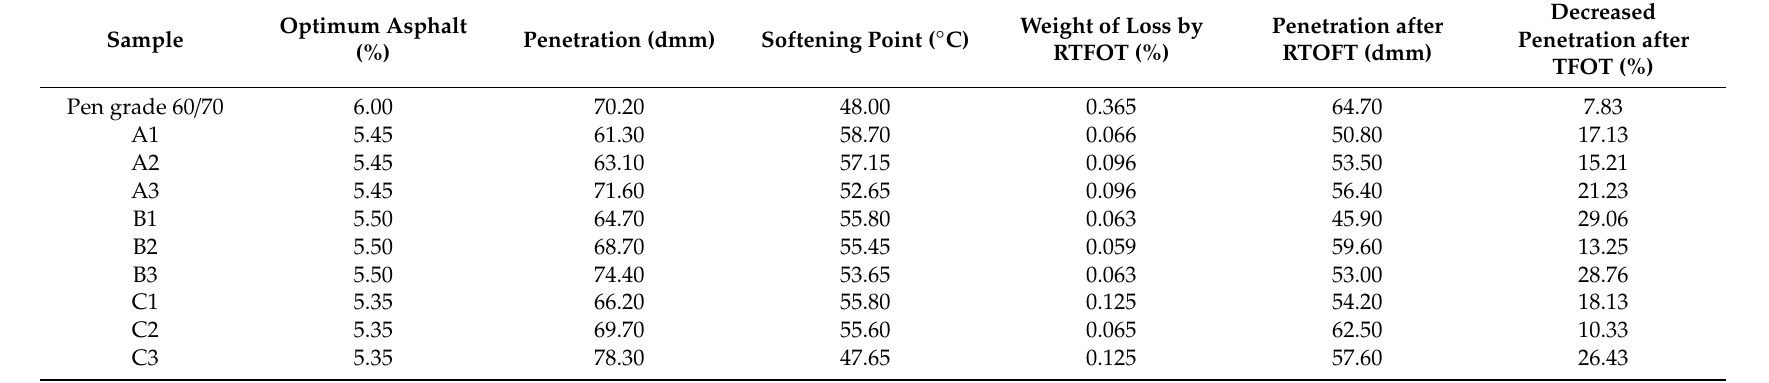
Table 4. Test results of modified asphalt